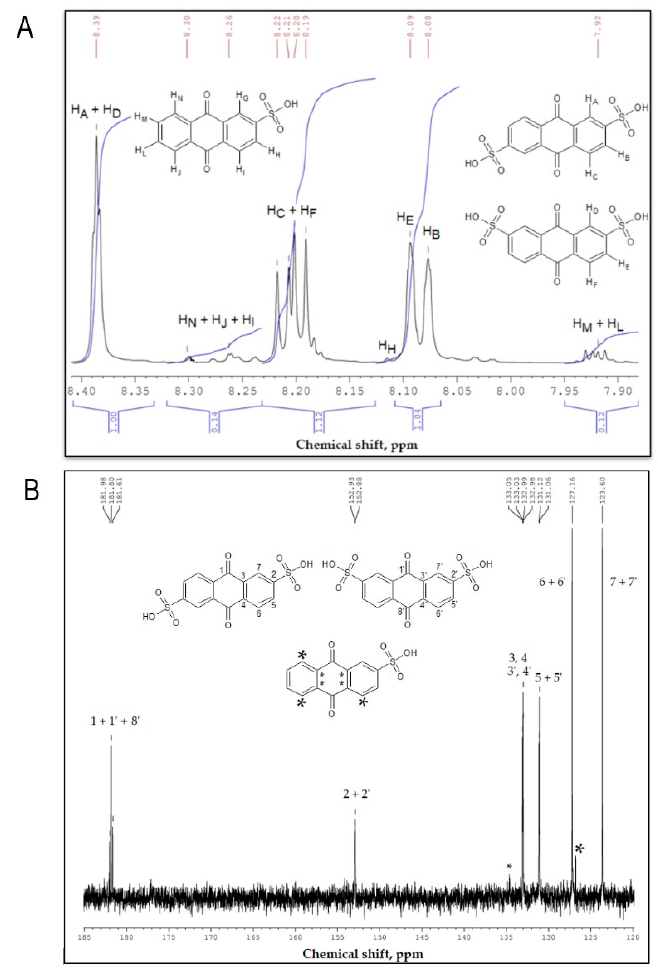
Figure 1. NMR (500 MHz, D 2 O) spectra of AS mixture. ( А ) 1 Н NMR ( B ) 13 C NMR.